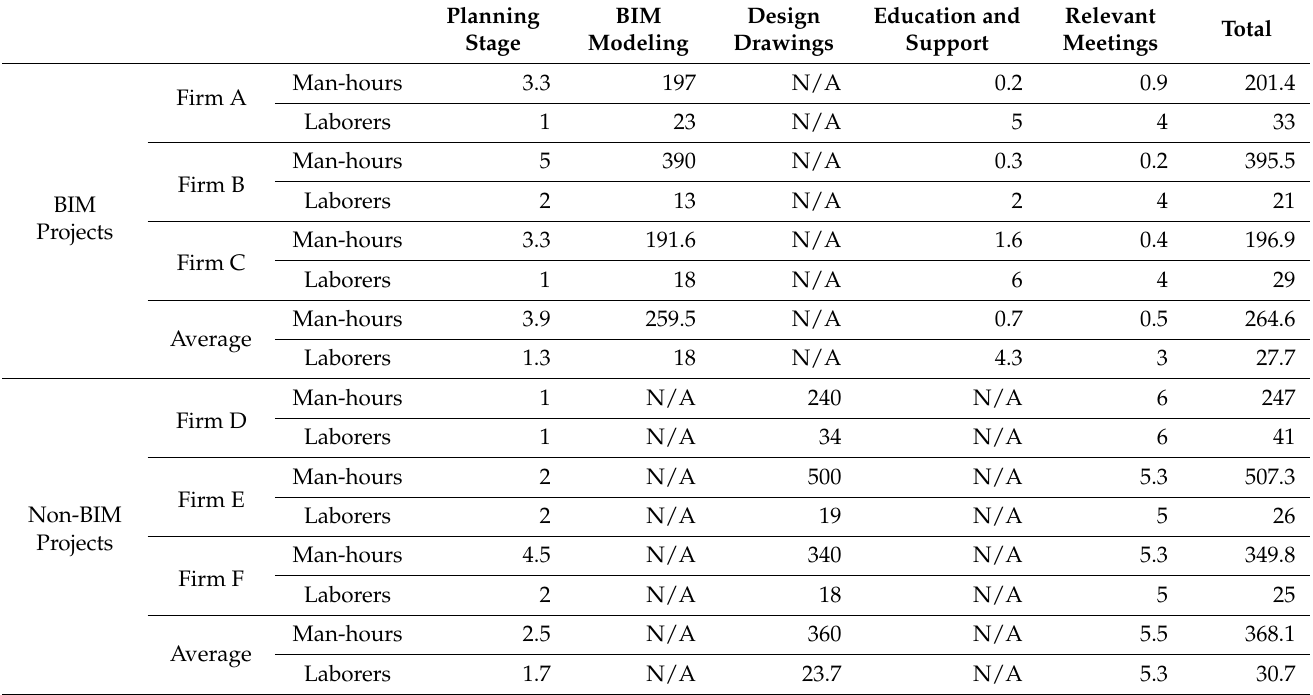
Table 8. Man-hour and labor comparison between BIM and non-BIM